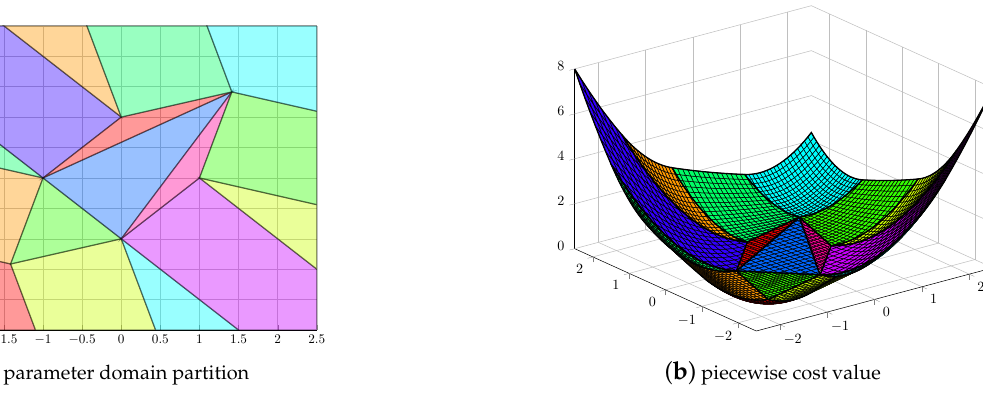
Figure 3. Representation of the multi-parametric